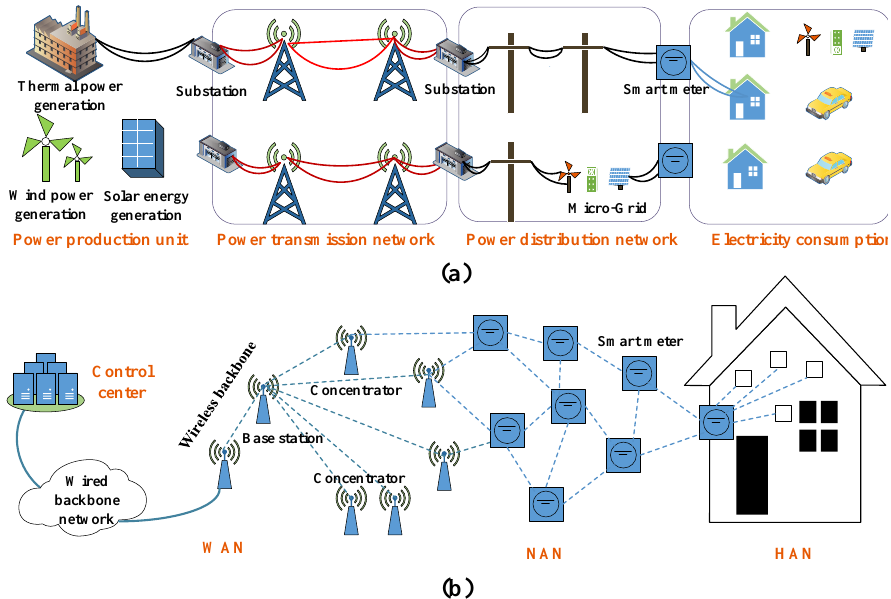
Figure 1. The structure of smart grid. ( a ) Power system layer; ( b ) Communication system